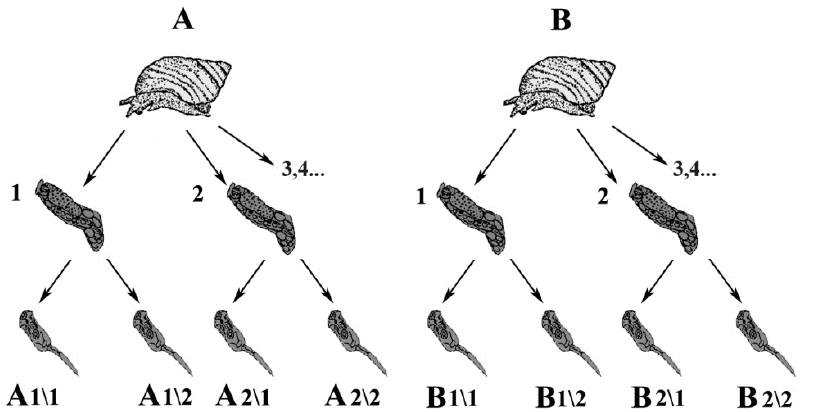
Figure 1. Nomenclature of clones selected for SAFLP [31]. A single miracidium infects the first intermediate host ( A , B ) and produces parthenogenetic generations of rediae ( A1 . . . ; B1 . . . ). They reproduce themselves to maintain the population and then produce free-living larvae—cercariae ( A1 / 1 , A1 / 2 , A2 / 1 , B1 / 1 , B1 / 2 , etc.). This nomenclature is used in Figure S2.